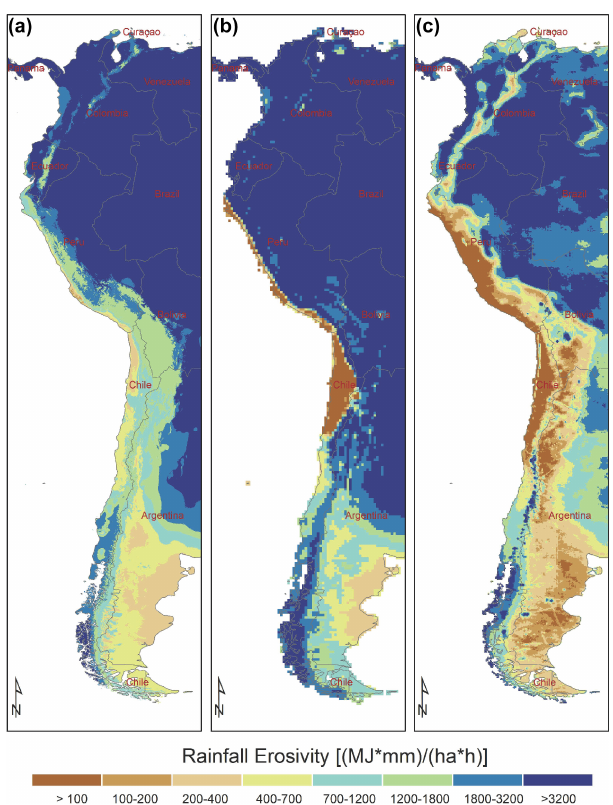
Figure 5. An example of worse agreement between the GloREDa (a) , ED (b) , and CMORPH (c) maps for the parts of South America.